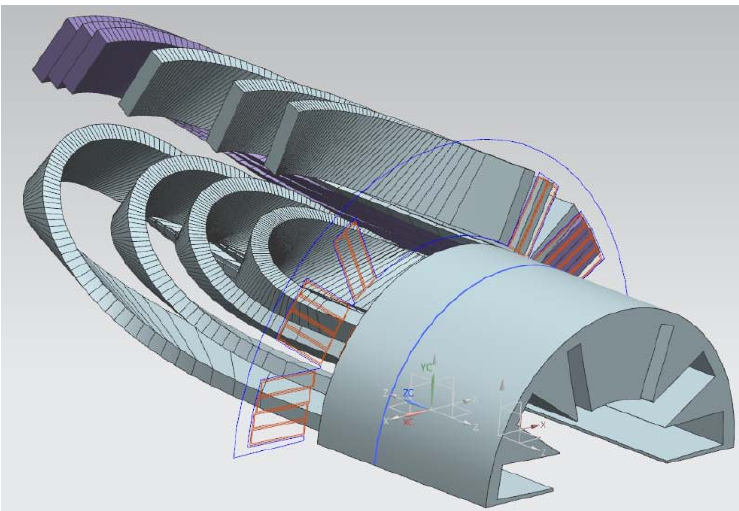
Figure 5. 3D view of coil turns in the coil nonlead end.